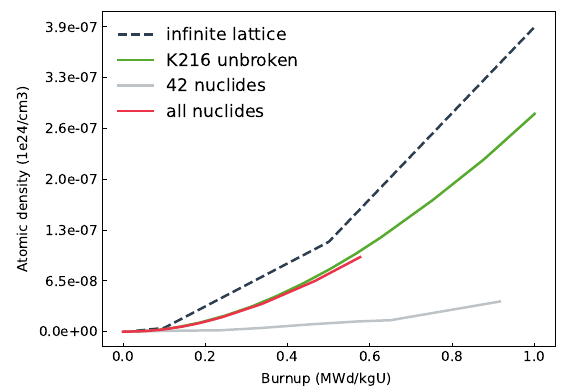
Figure 7. Short-term development of 239 Pu atomic densities for various calculation